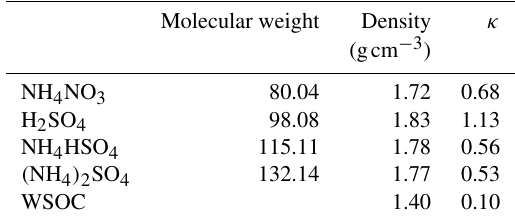
Table 1. Properties of each pure material. Molecular weight